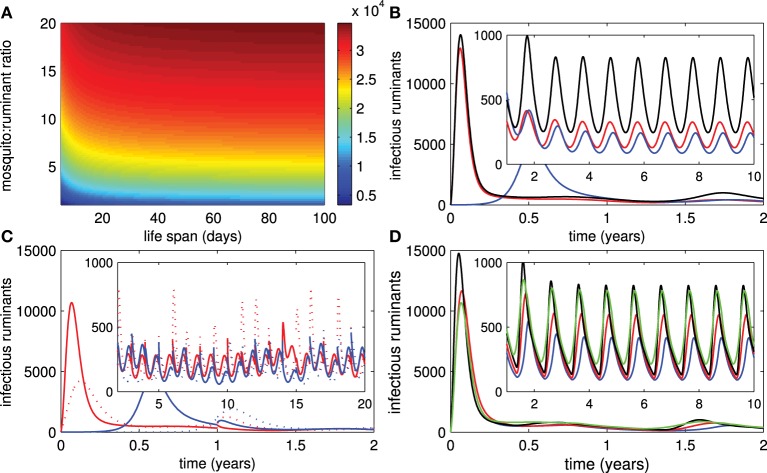
Mosquito activity. (A) The epidemic size of an outbreak according to changes in the mosquito lifespan and the mosquito:ruminant ratio. (B) The number of infectious ruminants changes according to the seasonal abundance of mosquitoes. (C) The changes in infectious numbers of ruminants relating to the yearly introduction of ruminants with different disease statuses during high and low levels of mosquito activity for live and killed vaccines (red and solid trace = introduction of ruminants during a low level of mosquito activity for live vaccines, red and dotted trace = introduction of ruminants during a high level of mosquito activity for live vaccines, blue and solid trace = introduction of ruminants during a low level of mosquito activity for killed vaccines, blue and dotted trace = introduction of ruminants during a high level of mosquito activity for killed vaccines). (D) The changes in infectious numbers relating to seasonal vaccination of live vaccines when the mosquito:rumiant ratio peaks during a rainy season (k0 = 2) and is less abundant in other seasons (k0 = 1) (blue trace = vaccination is not implemented in a rainy season which lasts 4 months, red trace = vaccination is implemented in a rainy season which lasts 4 months, green trace = vaccination is not implemented during a rainy season that lasts 6 months, black trace = vaccination is not implemented in the areas).